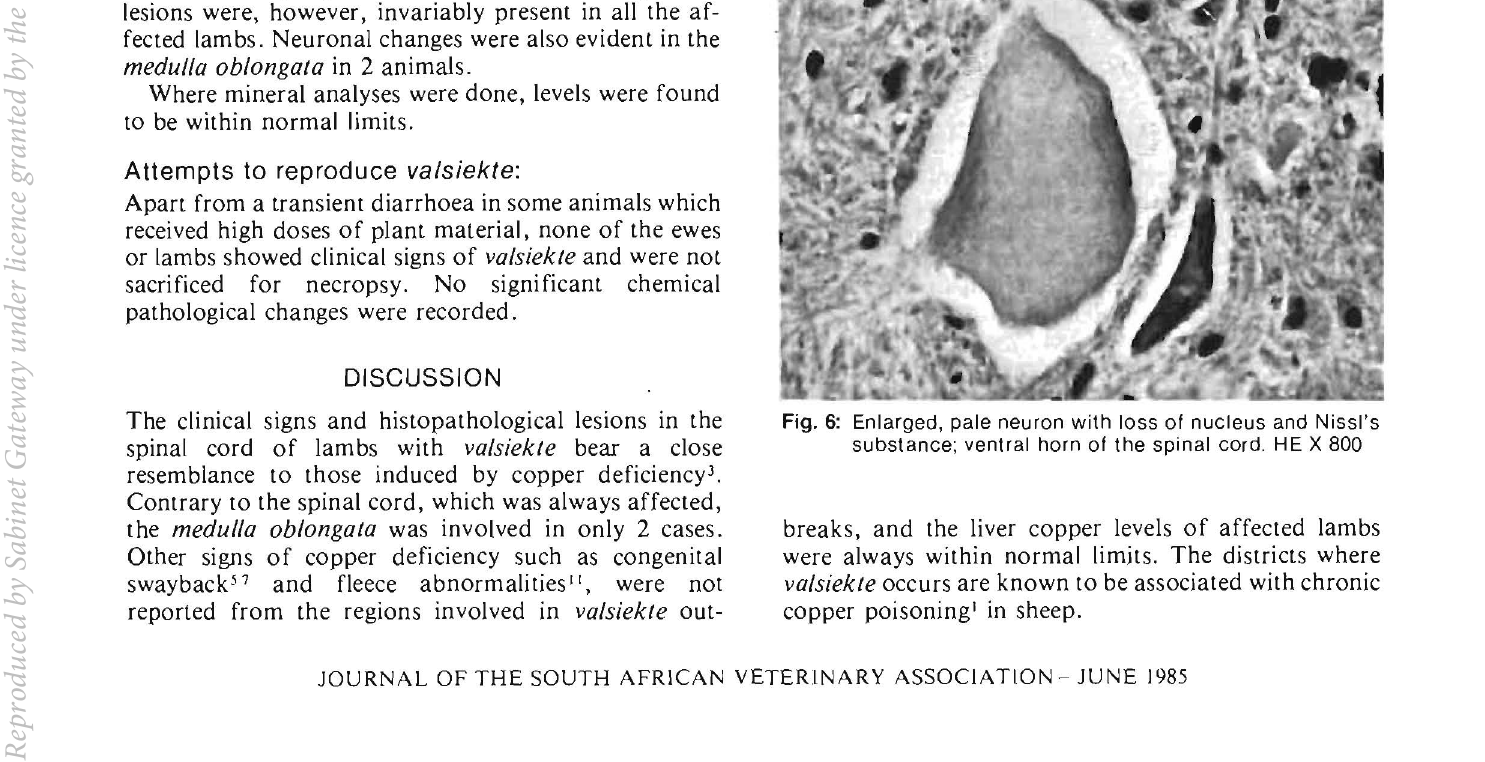
The neuronal changes varied in degree from small to large cytoplasmic vacuoles (Figs. 4 & 5), to enlarged neurons with pale, swollen eosinophilic cytoplasm and absence of Nissl's substance (Fig. 6). Their nuclei were often peripherally situated or absent.